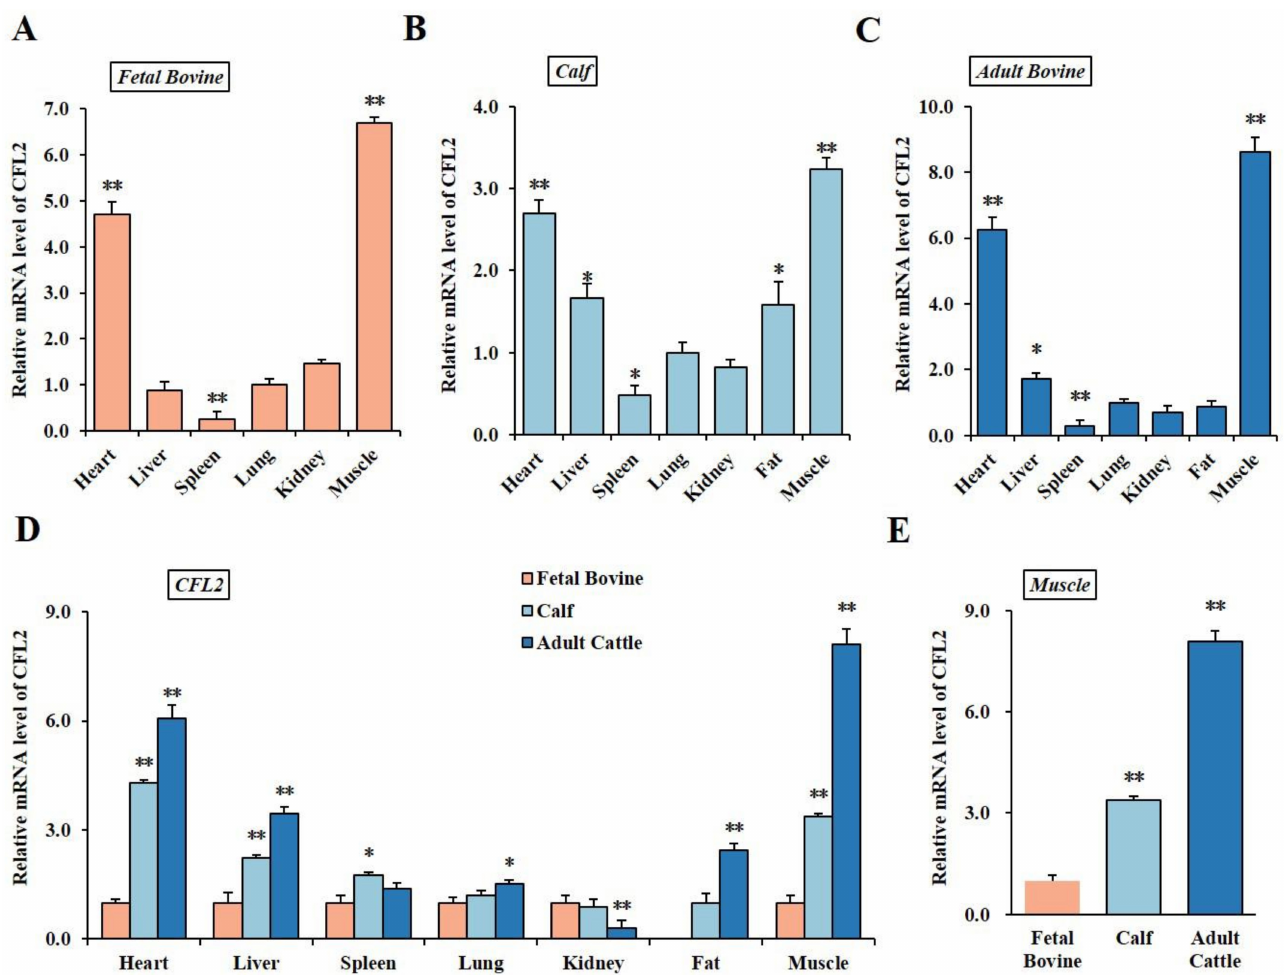
Figure 1. Spatiotemporal expression profiles of CFL2 gene in cattle tissues. qRT-PCR was used to examine CFL2 gene mRNA levels of spatiality in six tissues at FB stage ( A ), seven tissues at calf stage ( B ), seven tissues at AC stage ( C ); CFL2 mRNA levels in lung tissues were taken as 1. qRT-PCR was used to investigate CFL2 gene mRNA levels of temporally at three developing stages along with cattle age ( D , E ); CFL2 mRNA levels at FB stage were taken as 1. Due to the no fat deposition in FB stage, CFL2 mRNA levels at calf stage were taken as 1 in adipose tissues. Mean data ± SE of n = 3 independent experiments, each performed in triplicate, and normalized to GAPDH . * p < 0.05 and ** p <